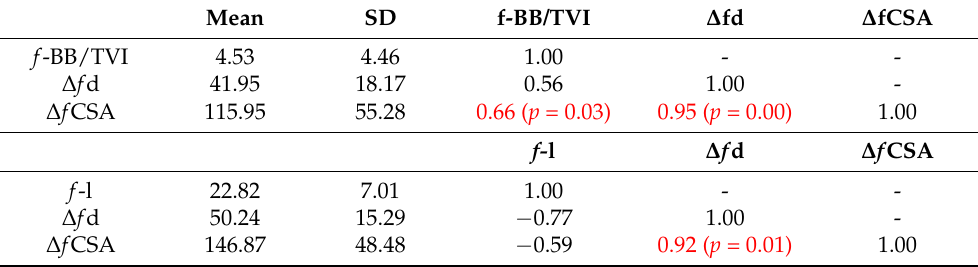
Table 3. Results of correlation analysis for the femur for t(I-S) = from 31 to 60 days. Correlation coefficients are statistically significant at p < 0.05 (in red).